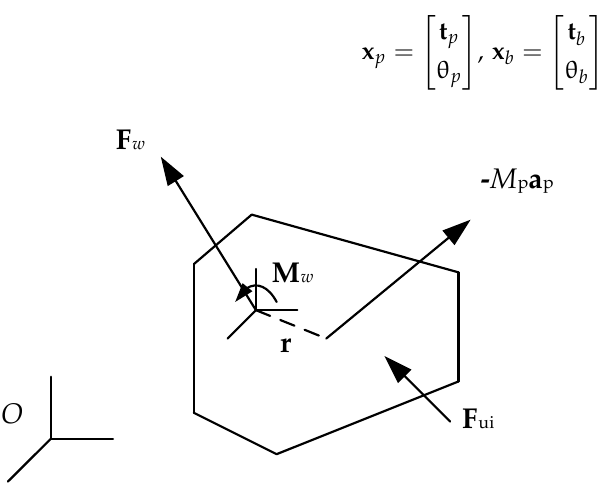
Figure 5. Free body diagram of the payload platform.